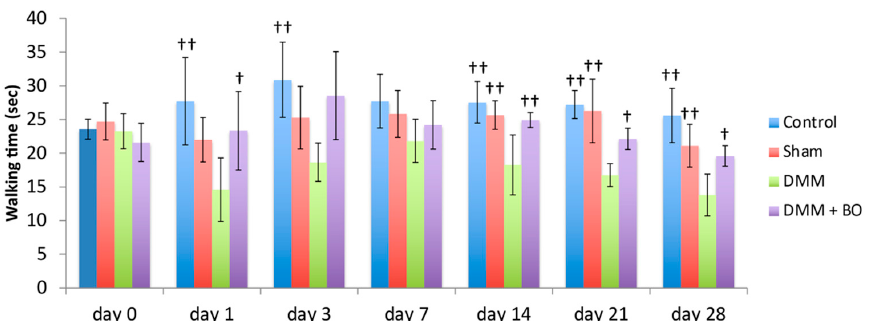
Figure 4. Locomotive functional test with the rotarod test. The stars indicate a significant difference from the DMM group by the Tukey–Kramer test ( † p < 0.05, †† p < 0.01 vs. DMM).